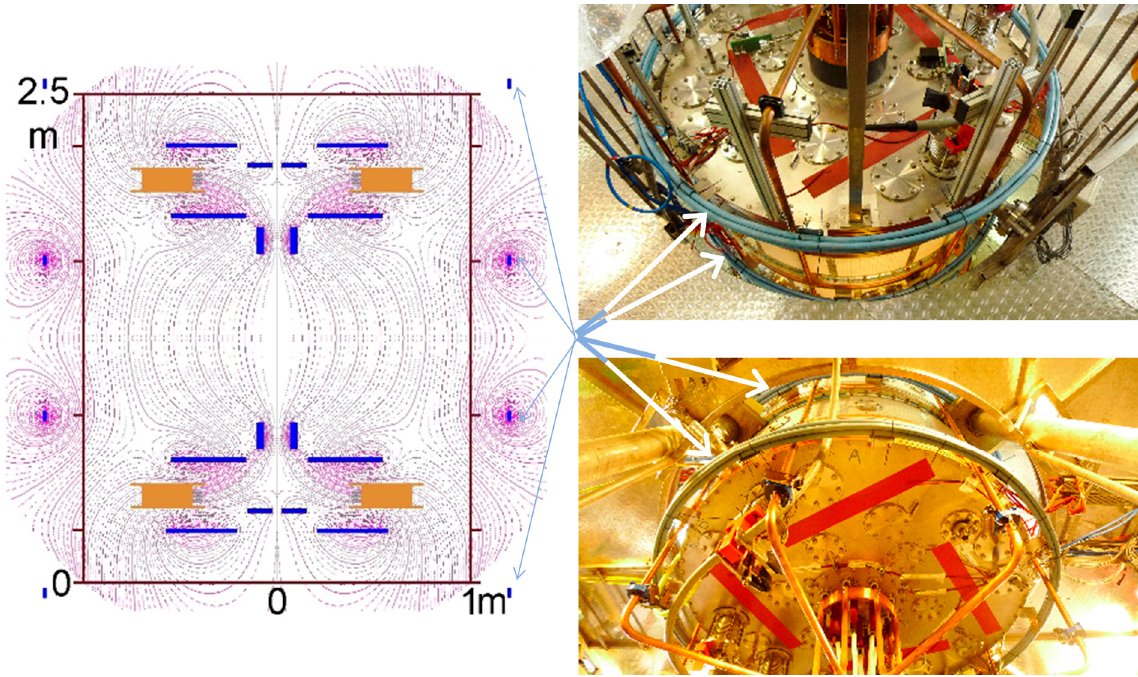
Figure 14. Location and impact on the magnetic fields of the additional external PFCs.